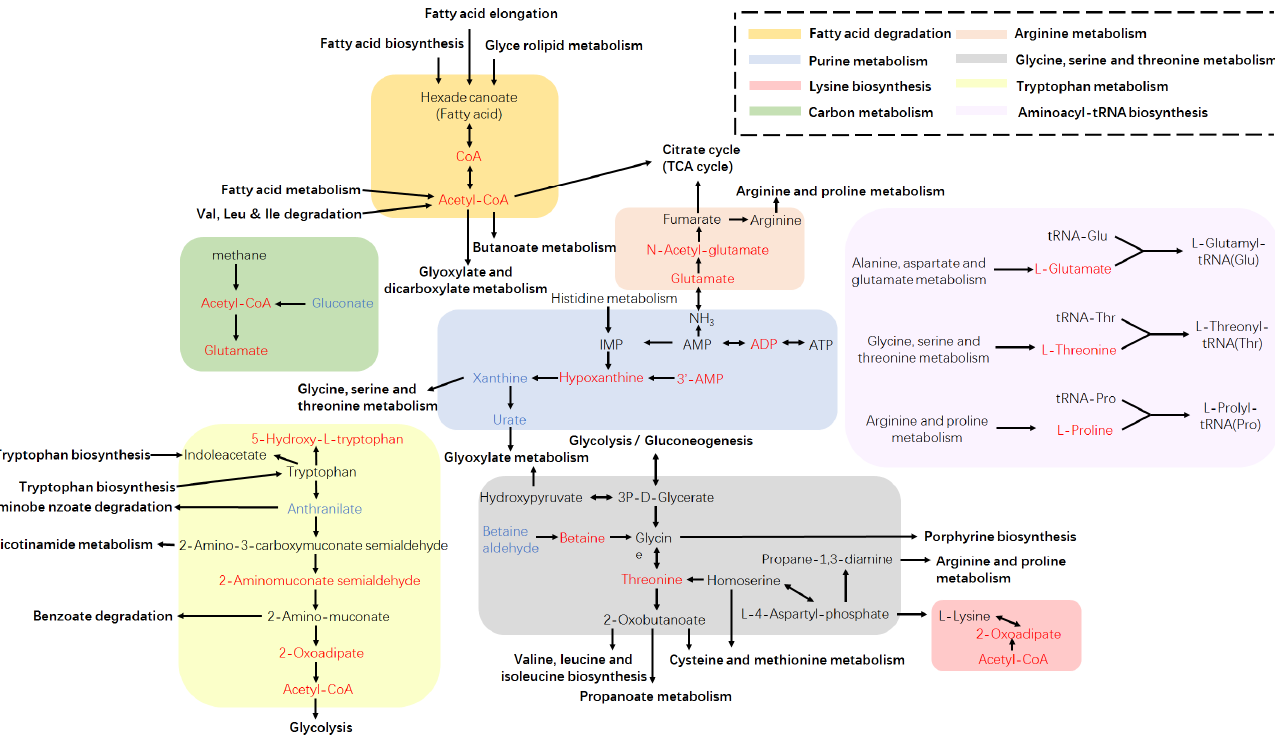
Figure 5. Changes in intracellular metabolites mapped to metabolic pathways for PT and PCK groups. The metabolites marked in blue and red indicate significant increases and decreases, respectively, in PT compared with PCK groups ( p < 0.05).